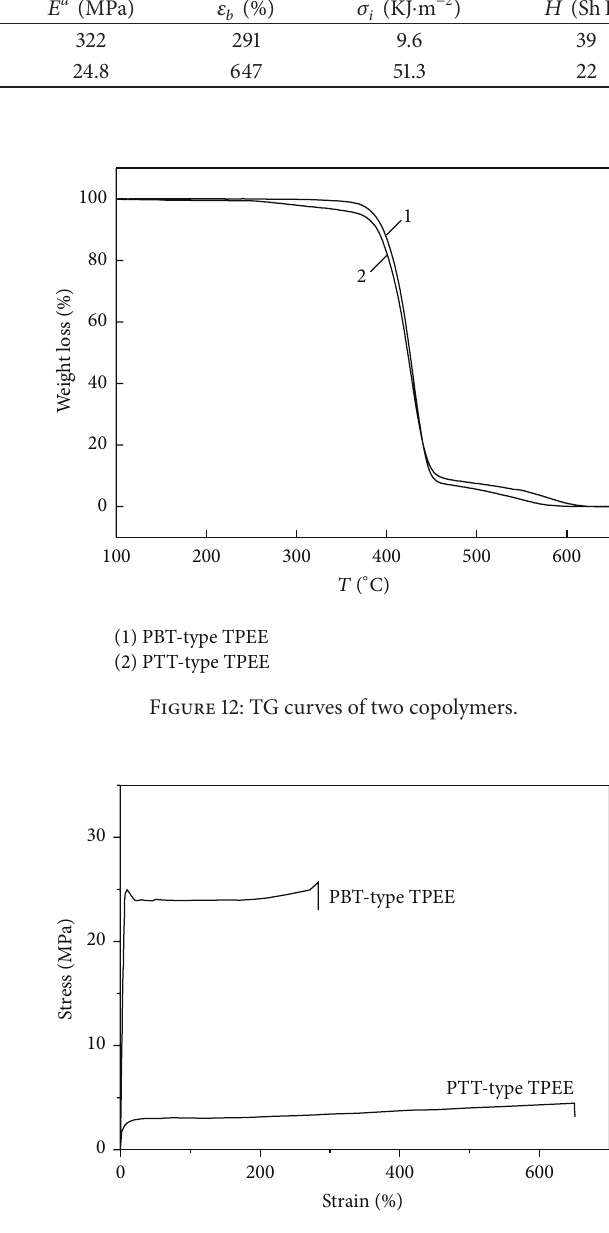
Figure 13: The stress-strain curves of two